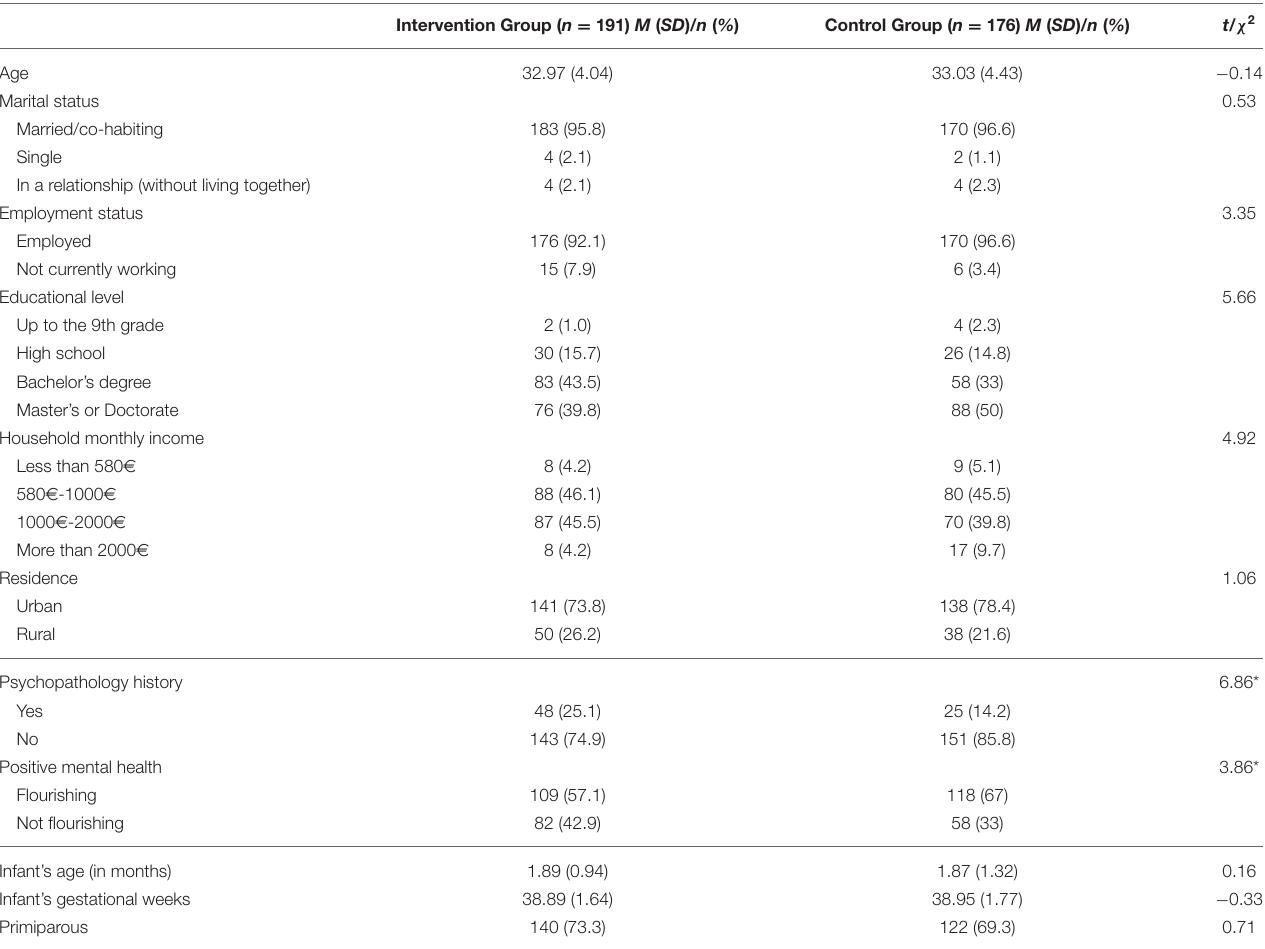
TABLE 1 | Participants’ background characteristics at